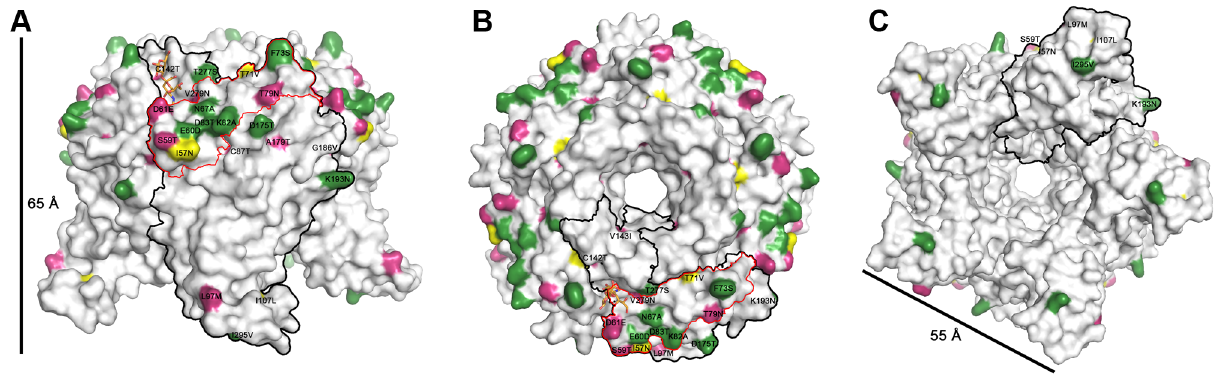
Figure 4. Mapping of differences between LPyV and HPyV9 VP1. The LPyV VP1 structure is shown in surface representation viewed from the side of VP1 (A), from the top of VP1 (B) and from the bottom of VP1 (C). The N-terminal arms were omitted for clarity. Residues that are unchanged between LPyV VP1 and HPyV9 are colored white, residues that are larger in LPyV VP1 than in HPyV9 are colored green, those larger in HPyV9 VP1 are colored magenta and those that are changed to a residue of equal size are colored yellow. The black outline encircles an LPyV VP1 monomer while the red outline delineates its BC-loop. Scale bars indicate the approximate dimensions of the pentamer.